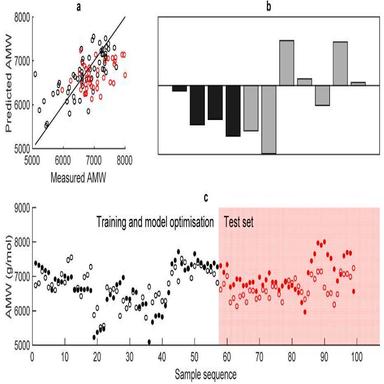
Preliminary results on a soft sensor for predicting average molecular weight (AMW) of salmon hydrolysates. (a) Predicted versus measured AMW, black circles represent predictions from training (cross-validation) while red circles are test set predictions. (b) Regression coefficients for raw material (black) and process (grey) variables. (c) Timeline of reference values (filled dots) and predictions (open circles) for training and test set. (For interpretation of the references to colour in this figure legend